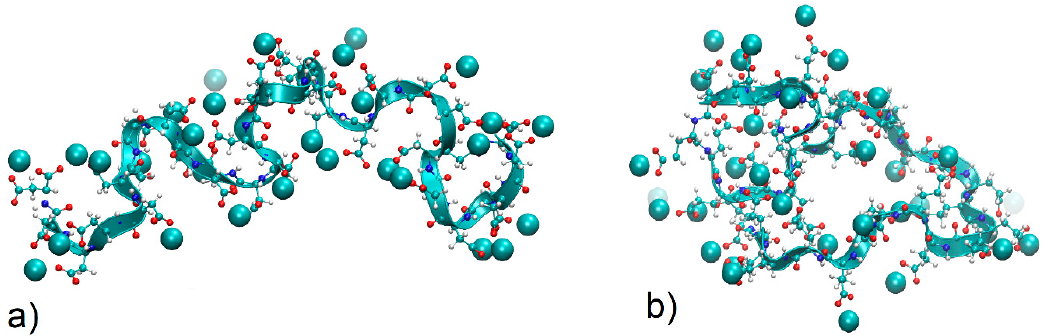
Figure 10. Snapshots of typical chain conformations with Ca 2+ ions bridging the carboxyl groups. ( a ) PASA and ( b ) PGA at 0.29 mol/kg CaCl2 solution.